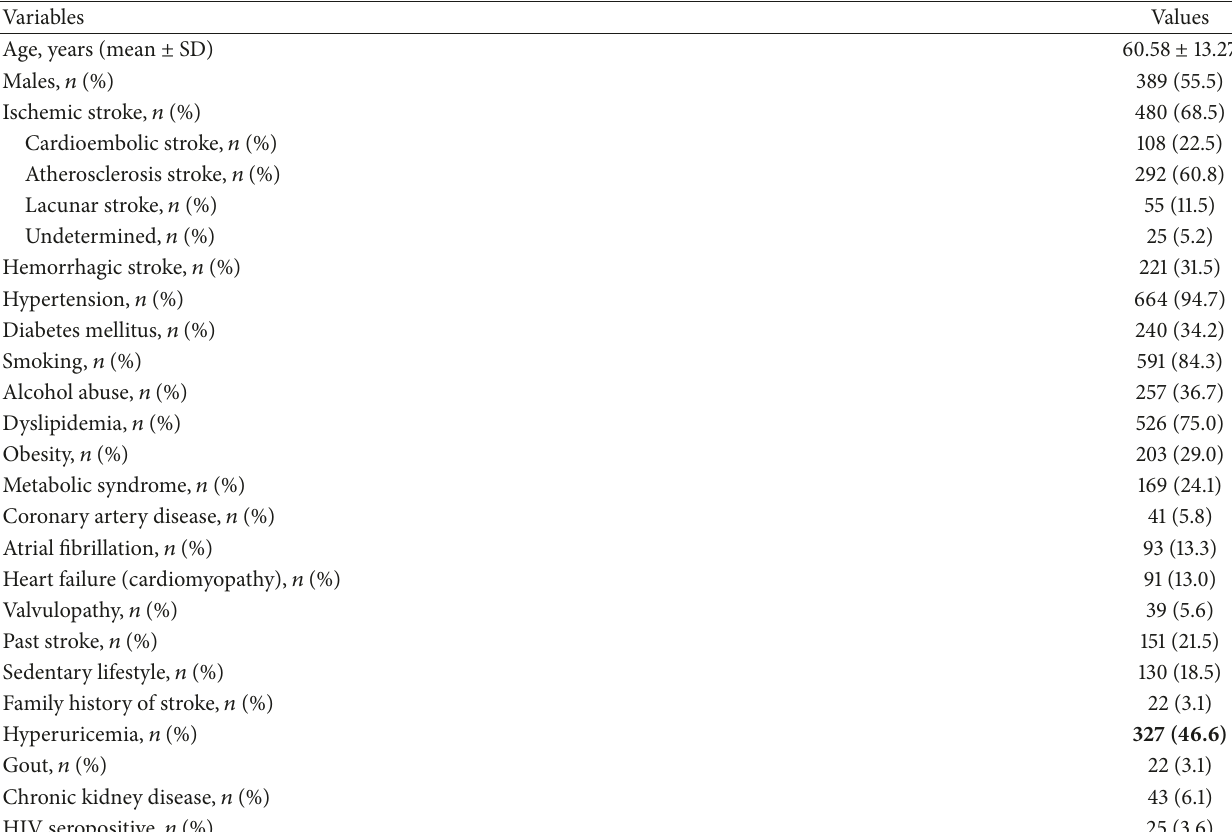
Table 1: Basic characteristics and cerebrovascular risk factors (CVRFs) of